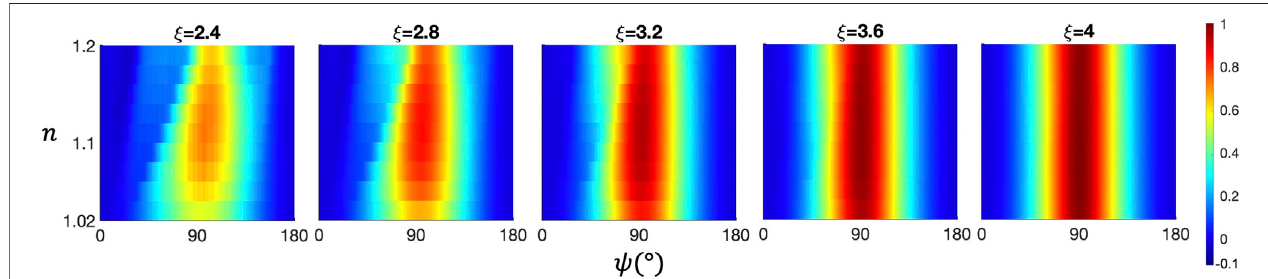
FIGURE 3 | Surface plots of the DoLP angular shape modeled with the asymmetric hexahedral particle light scattering model, same as Figure 1 .